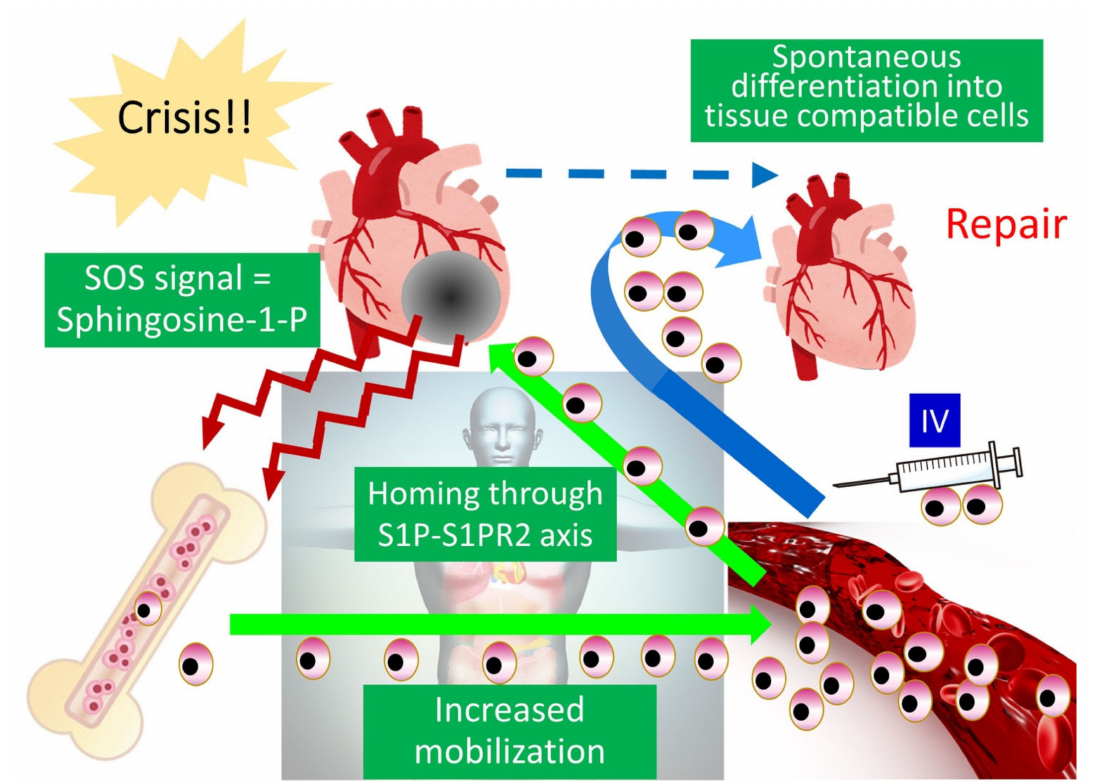
Figure 4. Strategy of Muse cell therapy. For example, in acute myocardial infarction, S1P as an alert signal is produced by the infarcted area and delivered to the bone marrow, where endogenous Muse cells are mobilized to the peripheral blood to increase the number of circulating Muse cells. The circulating Muse cells migrate to the infarcted area via the S1P–S1PR2 axis and replace damaged cells by spontaneous differentiation into tissue-appropriate cells to repair the cardiac tissue. When the number of endogenous Muse cells is insufficient, intravenous administration of exogenous Muse cells enhances the reparative activity, leading to successful tissue repair. This figure was reproduced with permission from Advances in Experimental Medicine and Biology (Springer, copyright 2018 [2]).